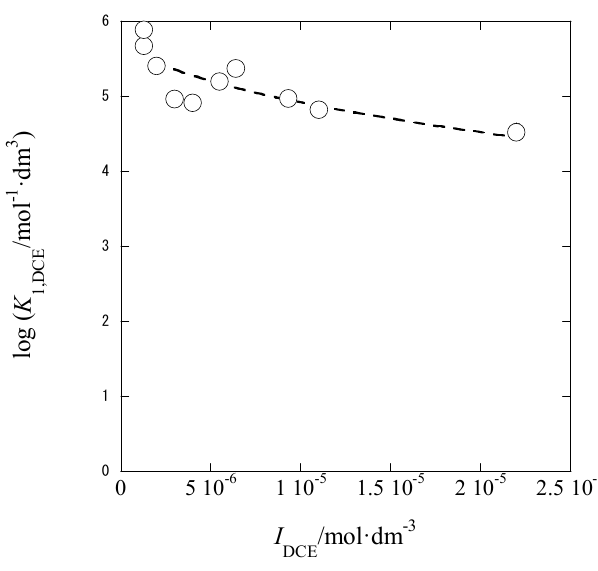
Figure 8. A plot of log K 1,DCE vs. I DCE for the AgPic extraction with B18C6 into DCE. The regression line was log K 1,DCE = 5.89 − 2×(1.52 × 10 2 ) I DCE (broken line) at r = 0.821 and N = 10. The logarithmic value, log K 1,DCEav , of simple average- K 1,DCE one was 5.36 ± 0.42 in the I DCE range